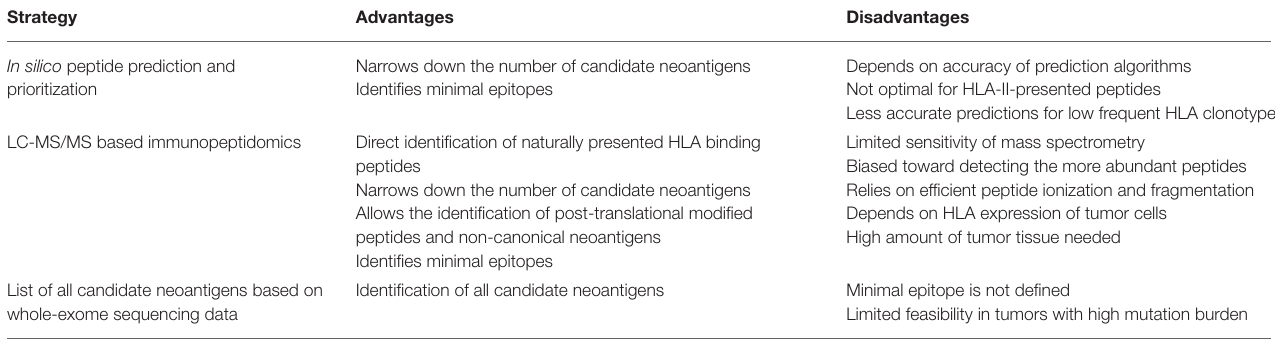
TABLE 1 | Strategies used for selection of candidate neoantigens.